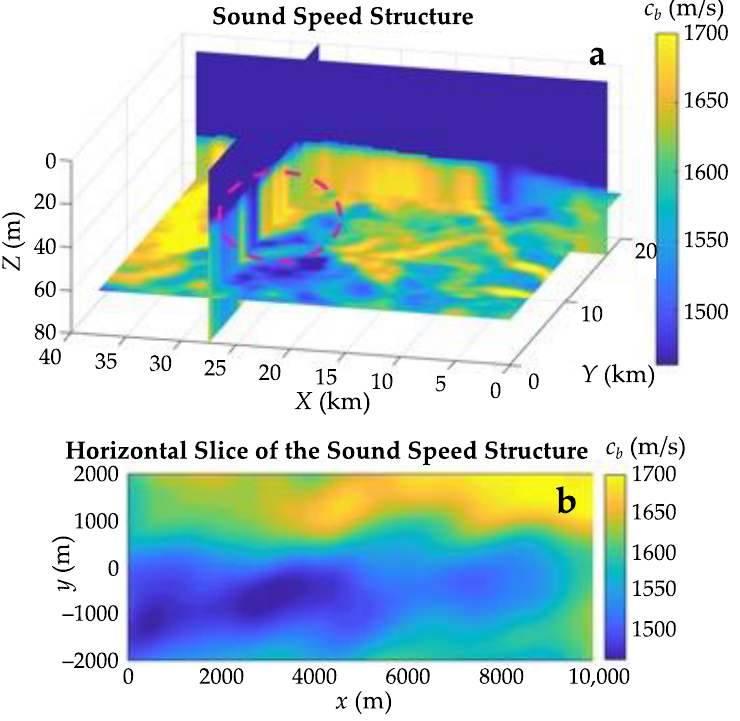
Figure 5. ( a ) The 3-D structure of the sound speed in one of the regions of the Kara Sea (the dashed ellipse indicates the part selected for numerical simulations; continuous dark blue area represents the water column); ( b ) horizontal slice of the sound speed structure inside the seabed at the depth of 41 m below the sea surface in the selected region; black circle depicts the location of a sound source (0,0,15 m).